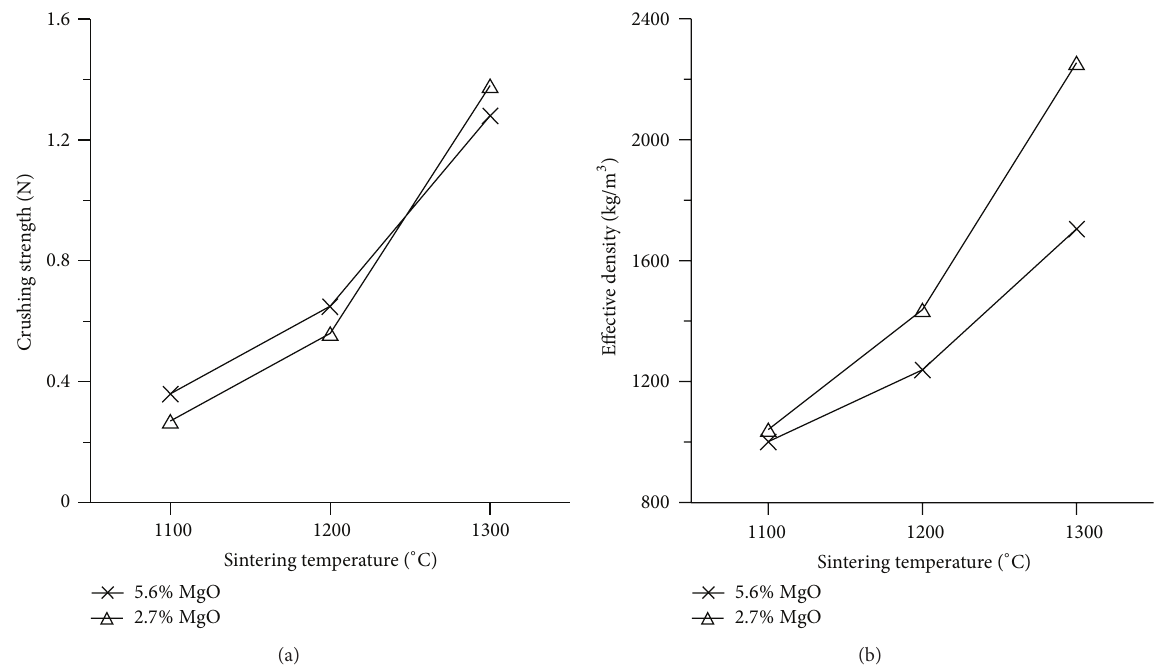
Figure 3: Crushing strength (a) and effective density (b) as a function of sintering temperature for all investigated particles.